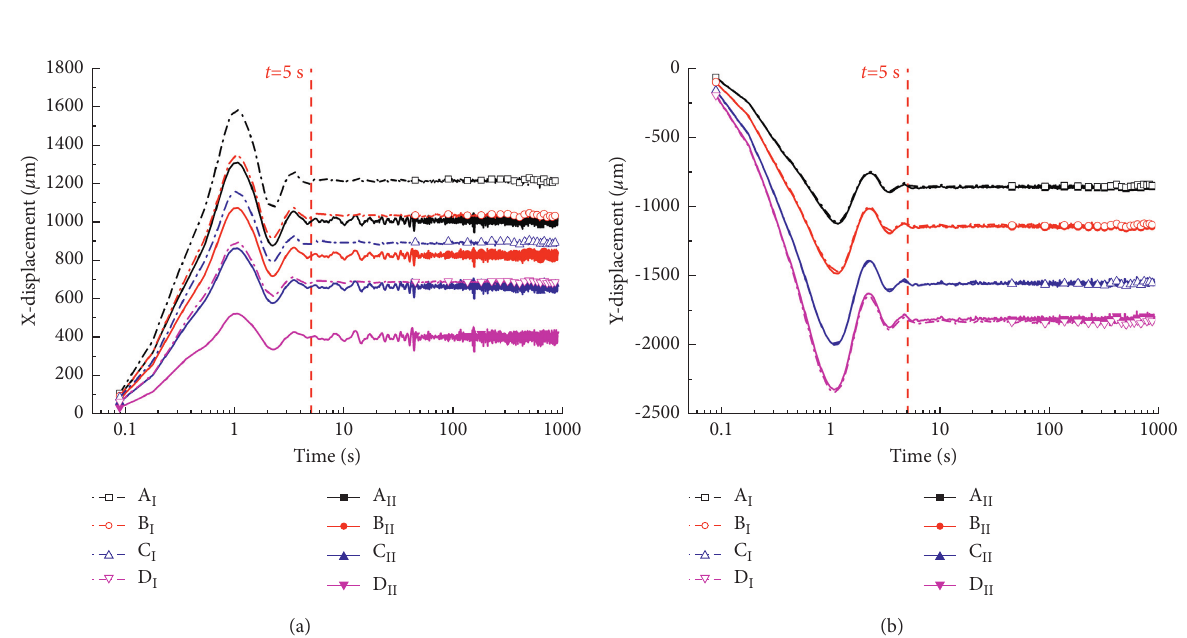
Figure 7: Time history curves of displacement. (a) X-displacement. (b) Y-displacement.